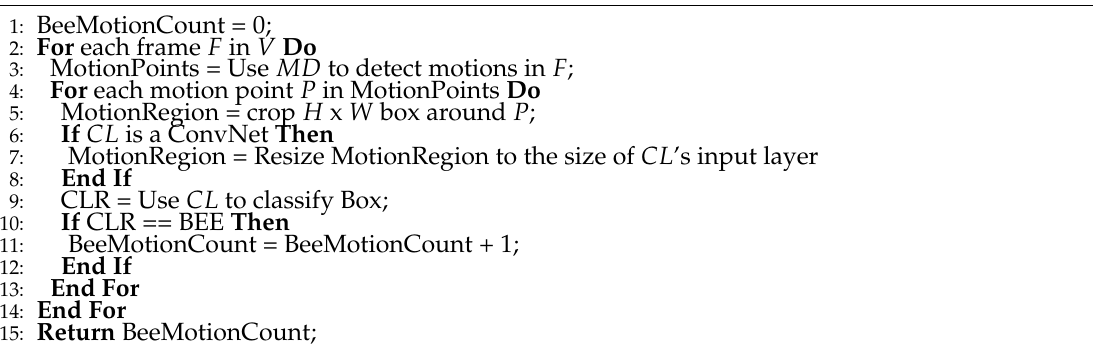
Algorithm 1 CountBeeMotions (Video V , MotionDetector MD , Classifier CL , int H , and int W